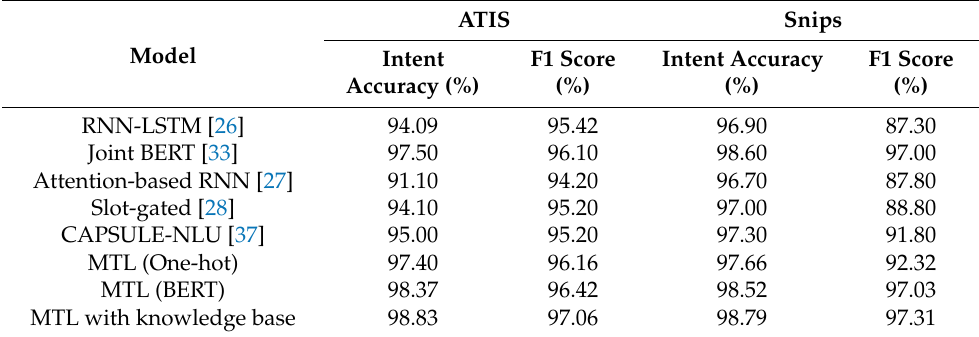
Table 2. Performance